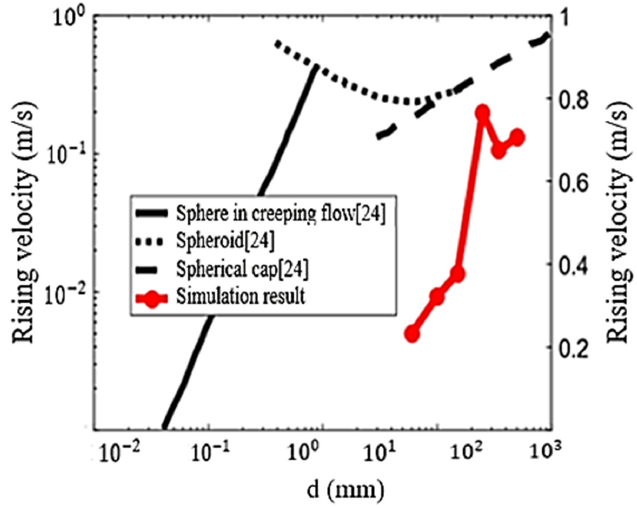
Figure 6. The rising velocity of bubbles compared with the referenced values.